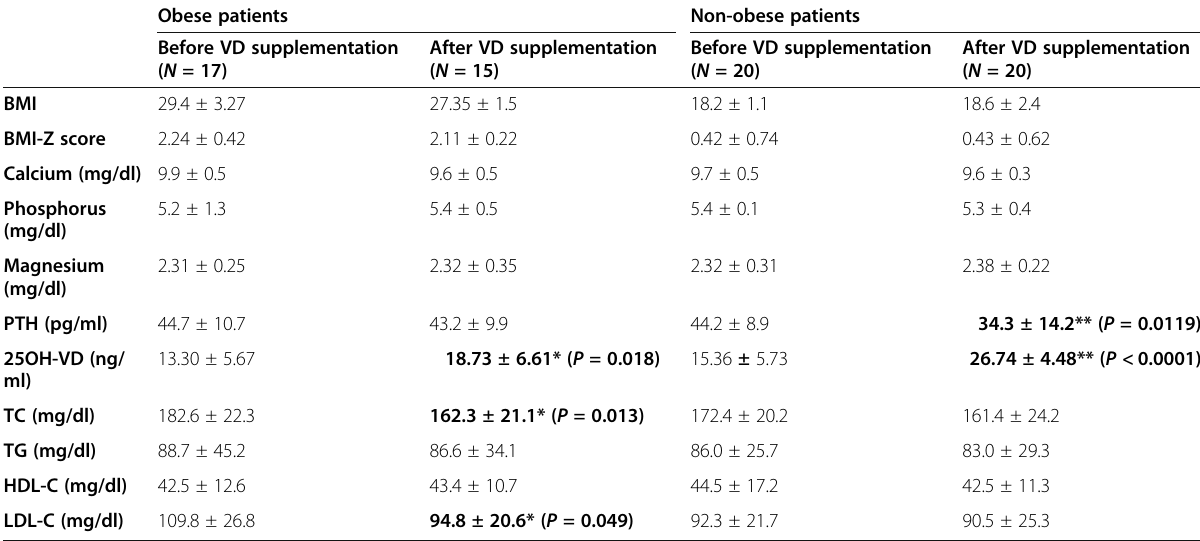
Table 3 Before and after VD supplementation anthropometric and laboratory data of the supplemented patients (obese/non-obese) (results presented as mean ±